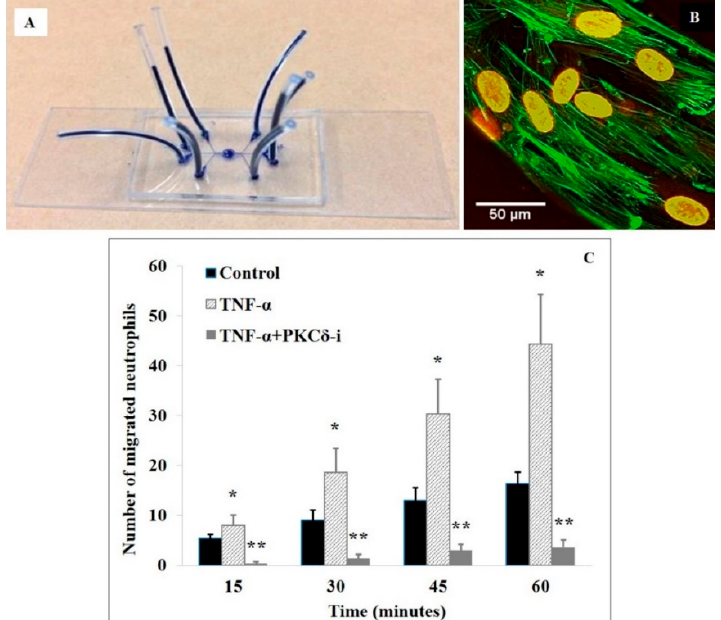
Figure 4. Microfluidic-based in vitro assay for studying the role of PKC δ in regulating neutrophil-endothelial cell interaction. ( A ) The assay is manufactured by soft lithography on polydimethylsiloxane (PDMS) and assembled on a microscope glass slide with plastic tubes (dark blue) allowing access to individual vascular channels and the tissue compartment. ( B ) 3D reconstruction of confocal images of human brain microvascular endothelial cells (HBMVEC) stained for F-actin with fluorescently labelled phalloidin (green) and for cell nuclei with Draq 5 (red) after 72 hrs of flow culture (0.1 µ L/min). ( C ) PKC δ inhibition with a PKC δ -TAT peptide inhibitor (PKC δ -i) reduces neutrophil migration across activated HBMVEC. Data are presented as mean ± SEM ( n = 3). ** p < 0.01, * p < 0.05 compared to the other two groups by ANOVA with Tukey-Kramer post-hoc. Reprinted with permission from Tang et al. 2018 [25].